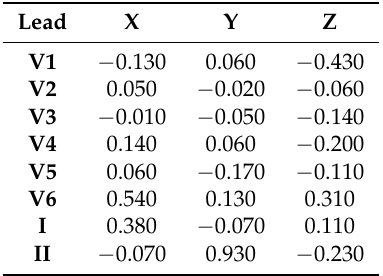
Table 2. Coefficients for Kors regression transformation.